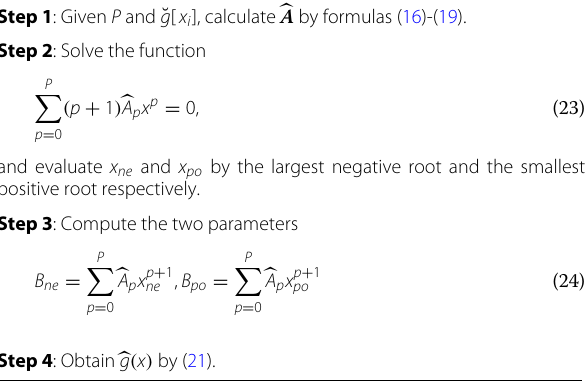
Table 2 Algorithm of ZMNL function